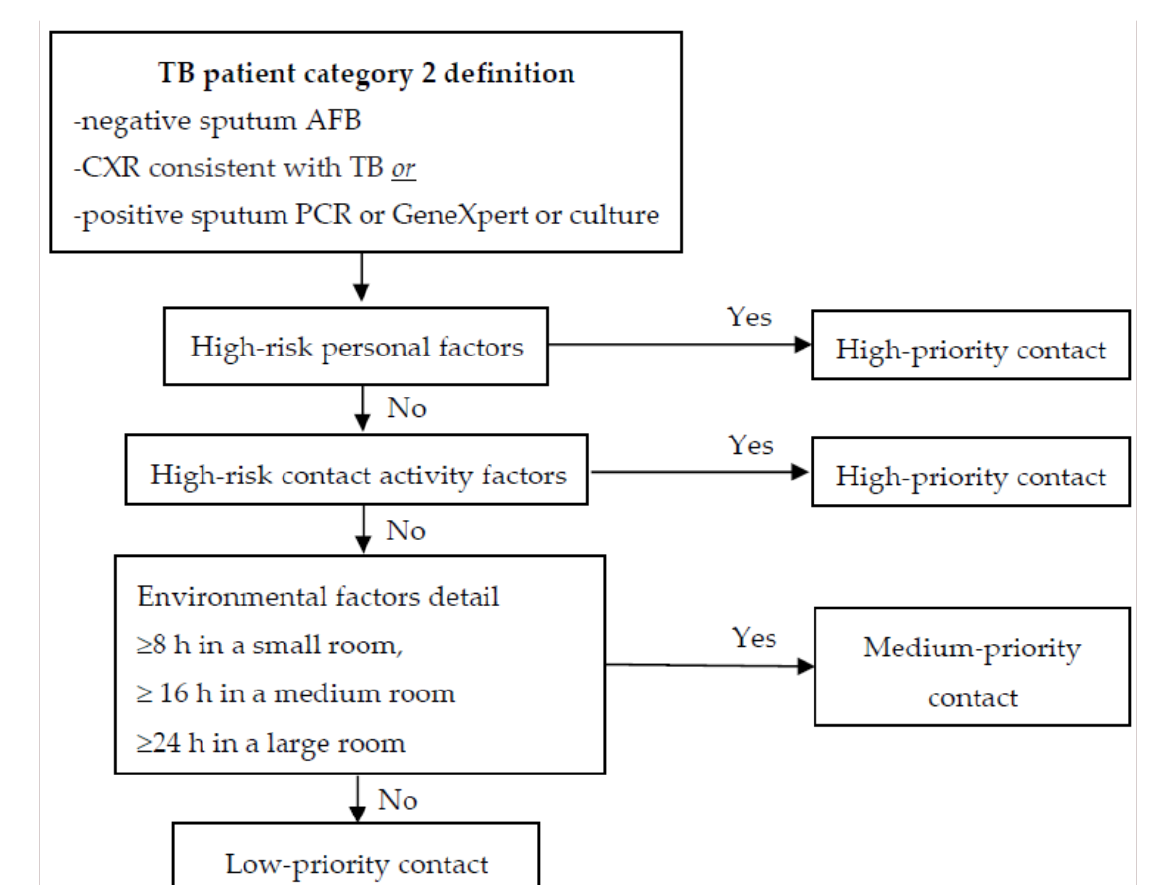
Figure 2. Prioritization of contacts exposed to TB Patient Category 2. (Source: OH&S Faculty of Medicine KKU Thailand).